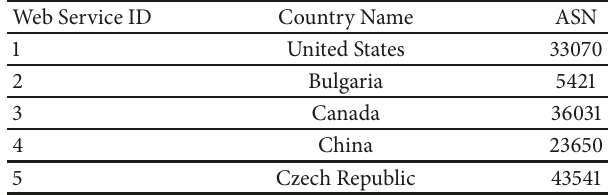
Table 3: Processed location information of Web services.